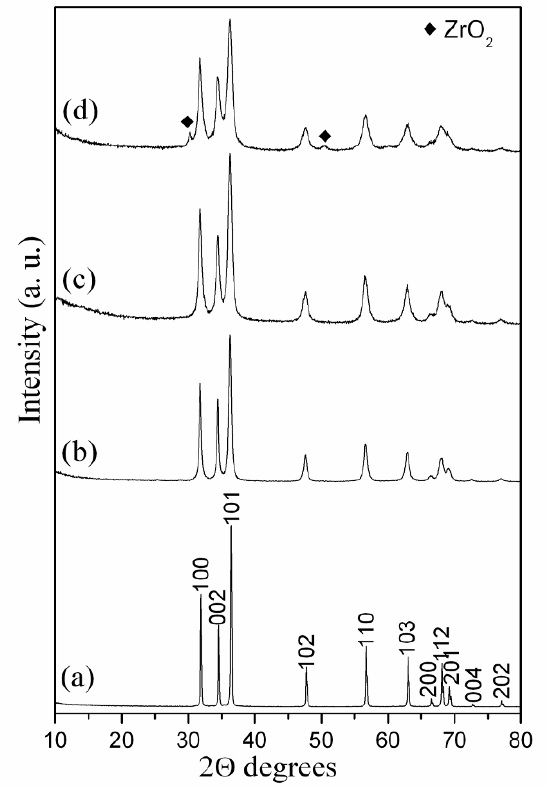
Figure 1. XRD patterns of: a) commercially ZnO; b) ZnO mechanically activated at 250 rpm, 10 h milling